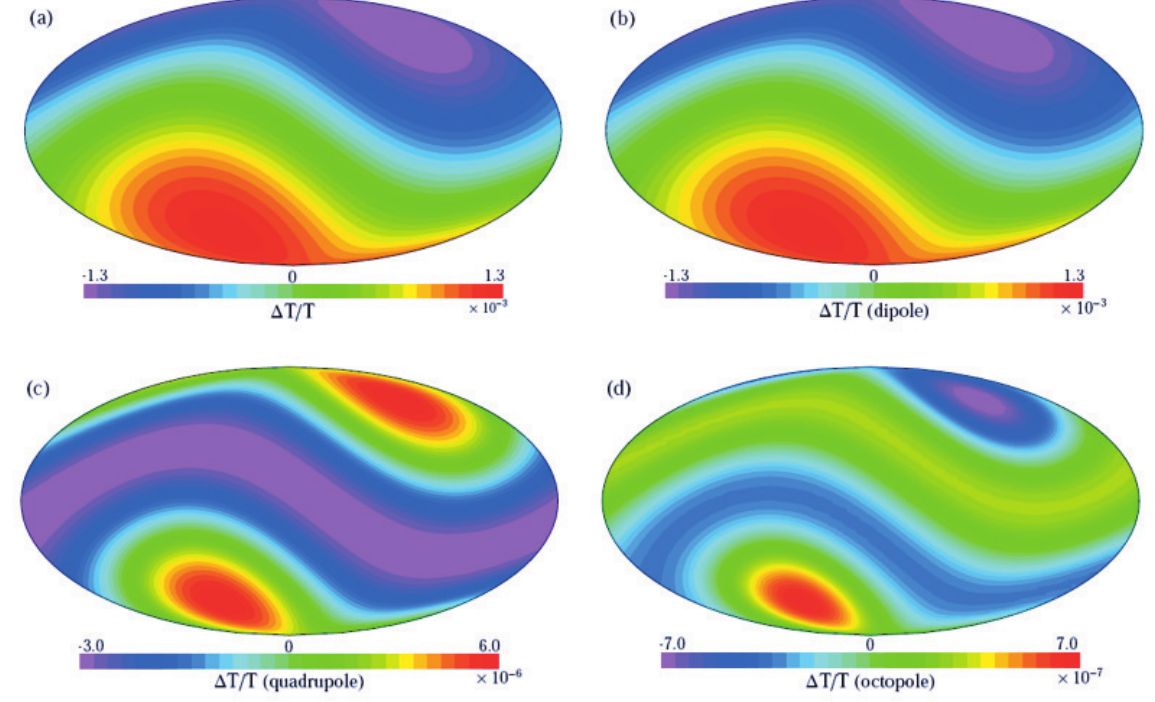
Figure 15. The predicted CMB maps of additional temperature fluctuations in galactic coordinates corresponding to the full map ( a ); dipole ( b ) quadrupole ( c ) and octopole ( d ). We have selected the direction of the preferred axis to coincide with the direction of the , Ω ) = (3 . 37 Gpc , 0 . 69) , r = 30 Mpc (from observed CMB dipole and used ( r 0 X, in obs